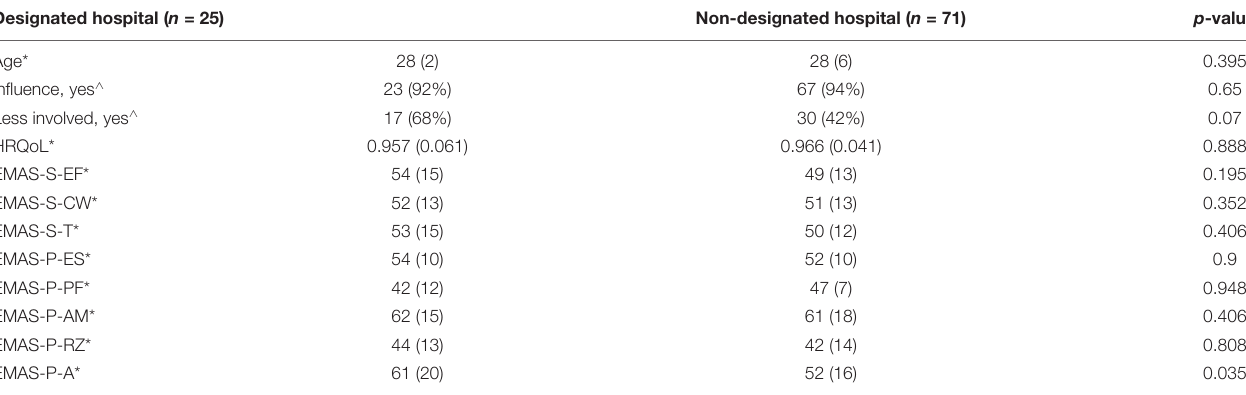
TABLE 3 | Evaluation of characteristics from designated hospitals vs. non-designated hospitals.